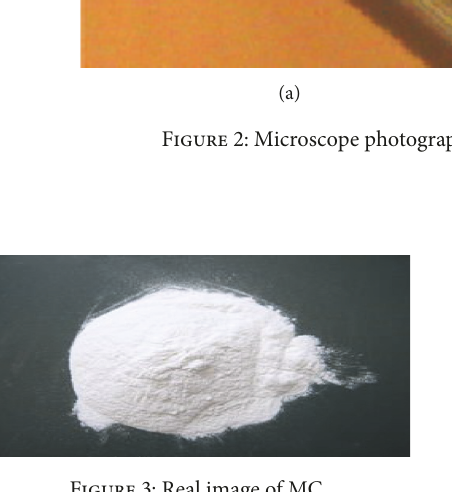
Figure 3: Real image of